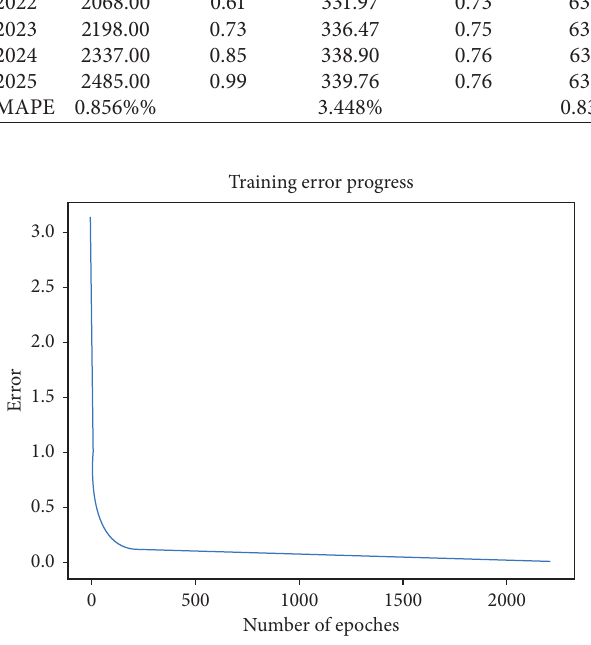
Figure 5: BP neural network training error process. Table 8: The container throughput results of Tianjin-Hebei Port Group forecasted by the grey combination model. The grey combination model forecast (unit: 10,000TEU)